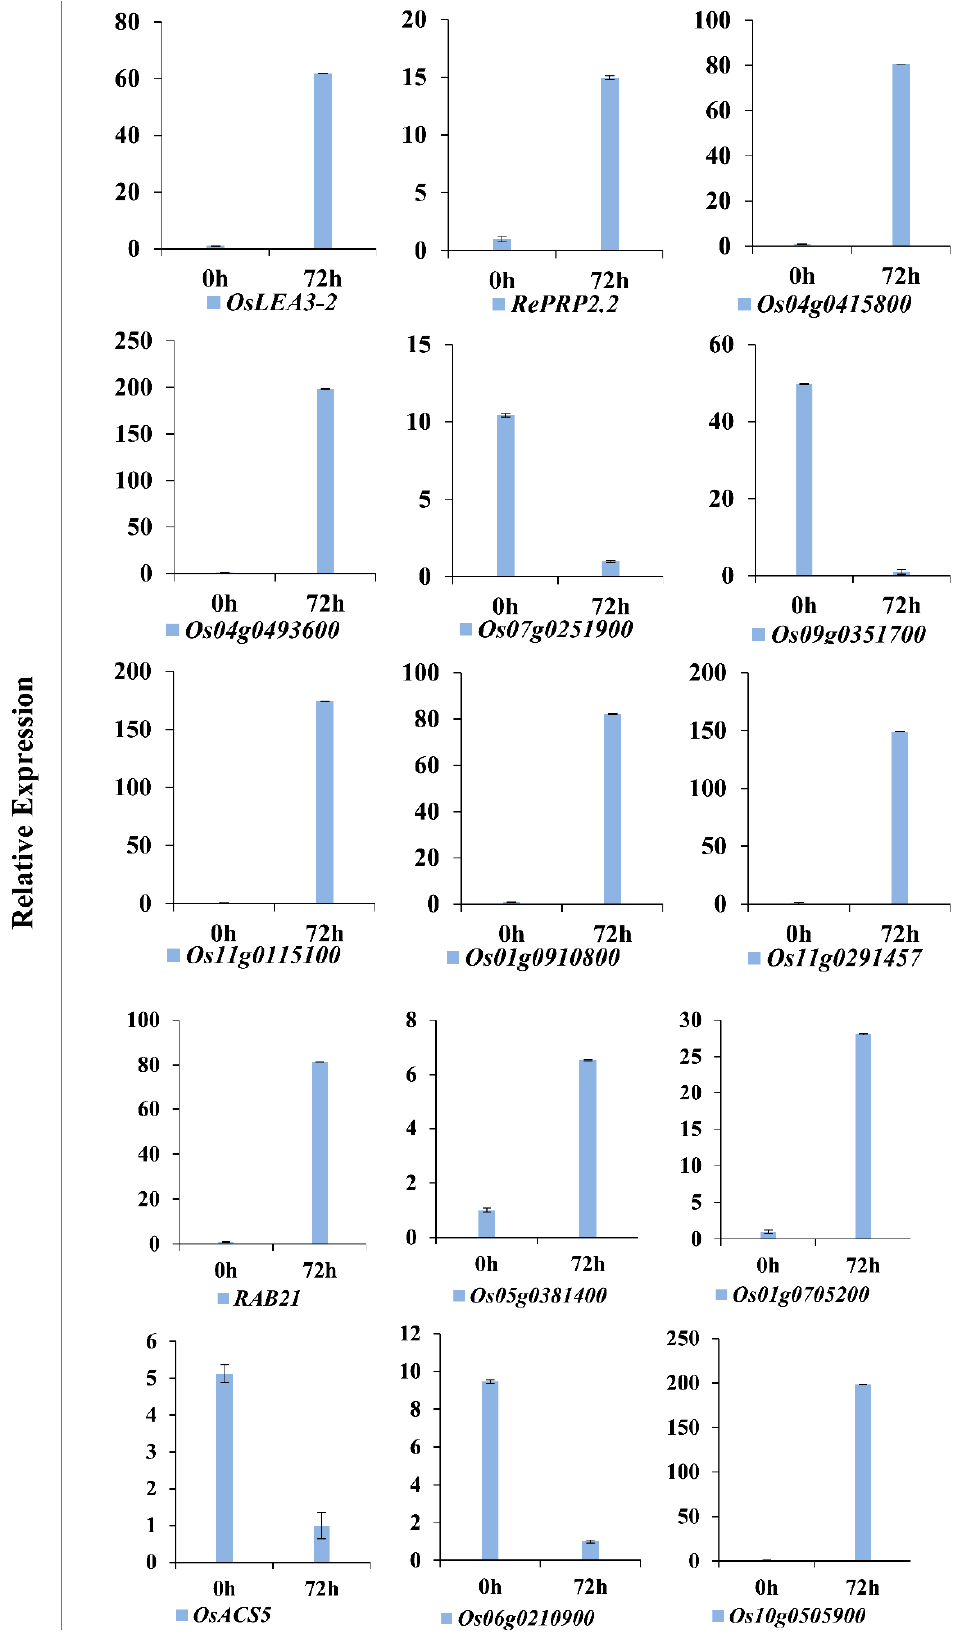
Figure 6. Confirmation of the transcriptomic profiles of selected genes by qRT ‐ PCR. The x ‐ axis shows the different periods of drought stress; the y ‐ axis shows the relative quantitative expression level of each unigene.